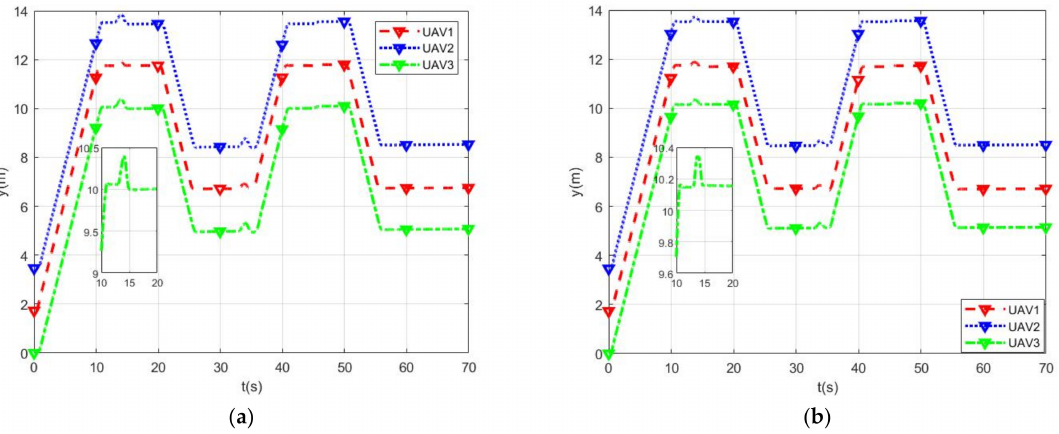
Figure 13. Trajectory tracking with RMPC ( a ) and IMPC ( b ) in the y -axis direction in Case 2. The UAVs in the formations with IMPC and RMPC are able to maintain their relative distance from the y -axis. However, IMPC is able to return to the steady state faster and has better robustness against impulse.